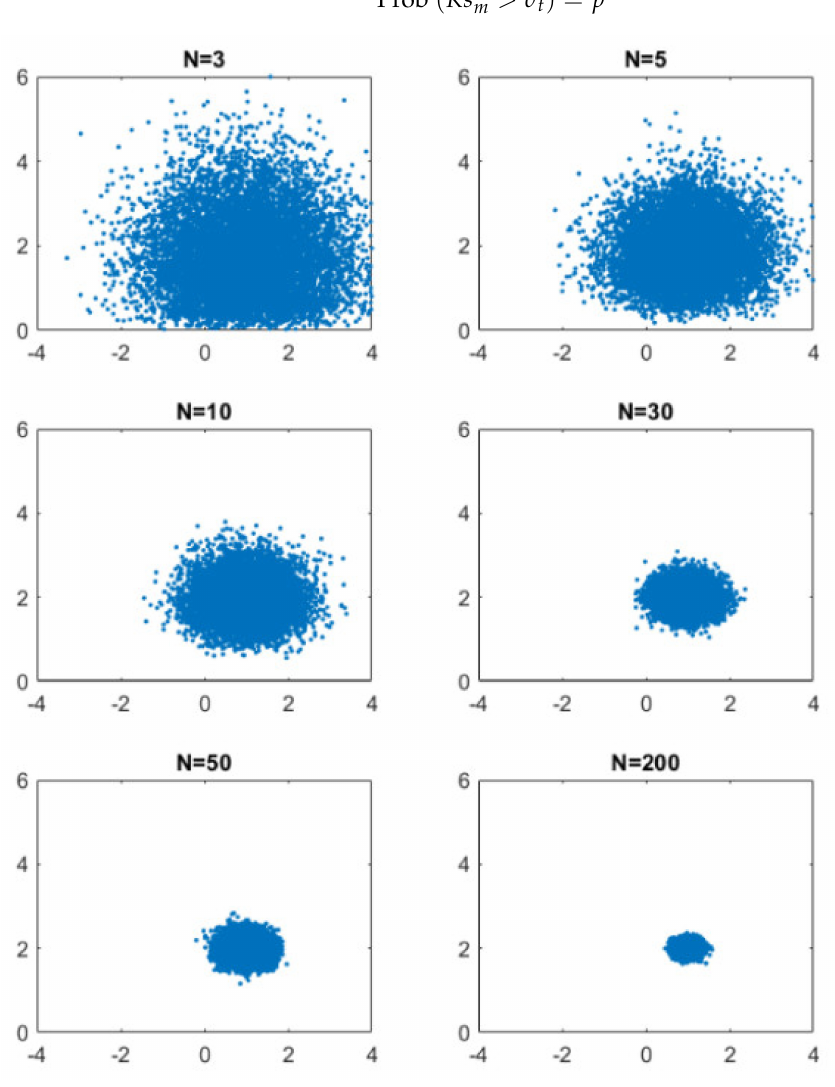
Figure A6. Joint distribution of samples' means and standard